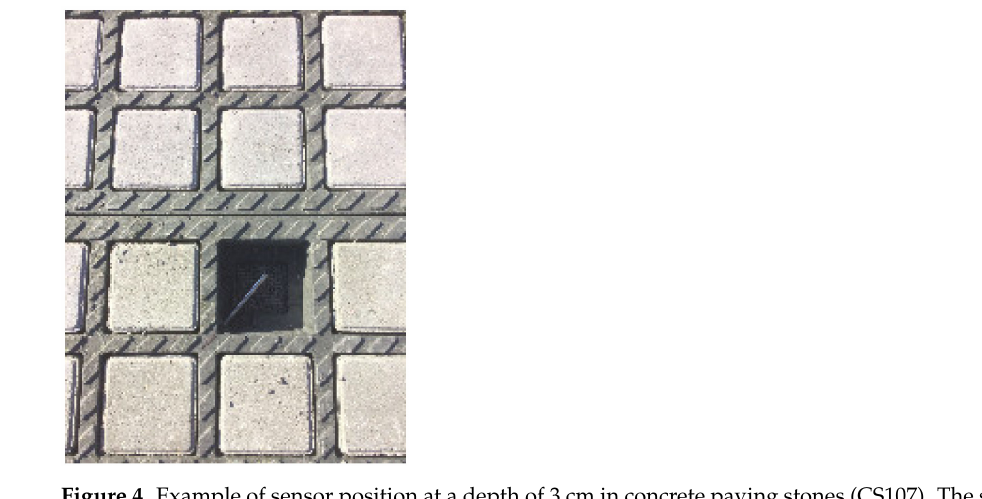
Figure 4. Example of sensor position at a depth of 3 cm in concrete paving stones (CS107). The sensor was placed inside a paving stone. Table 2. Description of the four parking lots (PLs) and the control zone (CZ9).